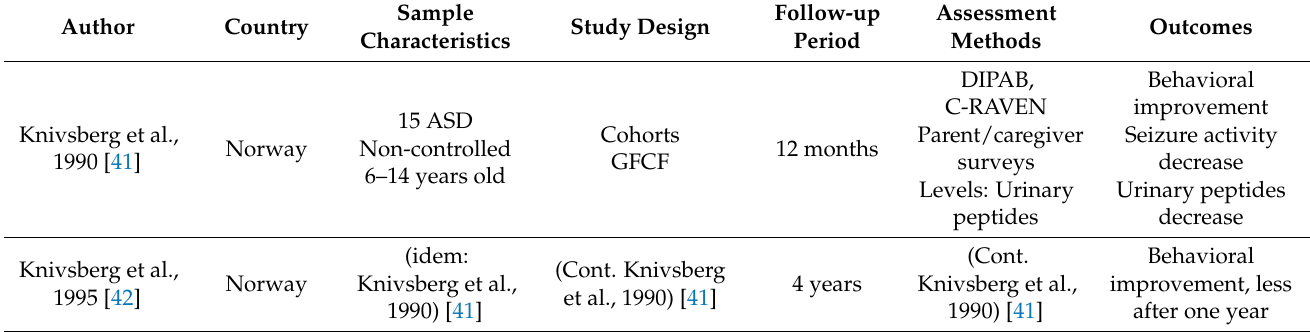
Table 1. Main studies (in chronological order of publication) concerning the efficacy of gluten-free, casein-free diets in autism spectrum